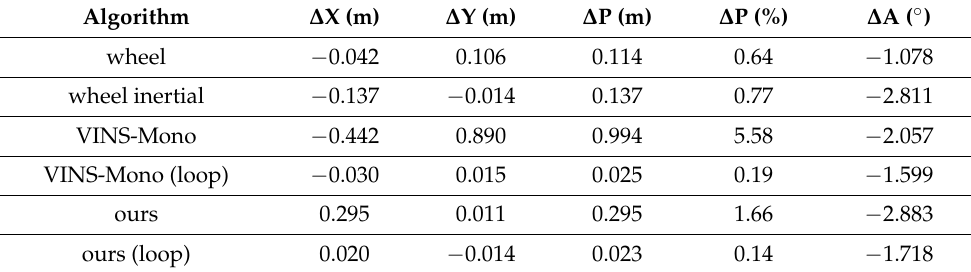
Table 3. Pose measurement results when visual tracking was